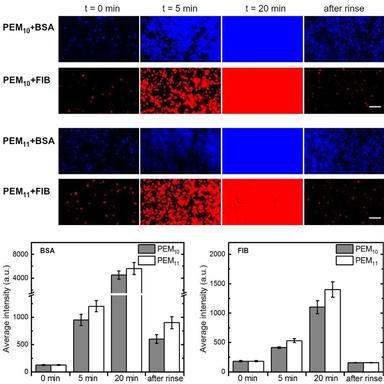
Representative TIRF micrographs during protein adsorption experiments on PEM surfaces (top). Scale bar = 5 μm. The images at 20 min appear to be saturated, however they are not. The brightness and contrast are adjusted so that the adsorbed proteins at t = 0 are visible. See Vid. 2 (in Supplementary Data), the contrast for which is adjusted differently. Average intensity of fluorescently labeled protein in the TIRF microscopy images (bottom). The error bars represent standard deviations (n = 3 independent ex